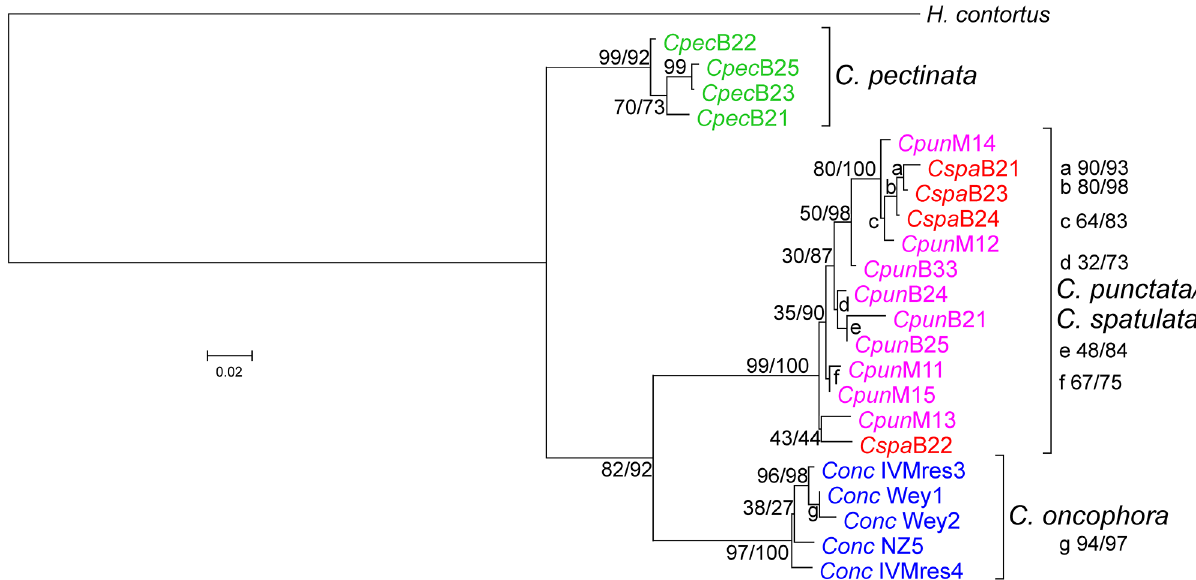
Fig 6. Multi-locus phylogenetic analysis of Cooperia species infecting cattle. Sequences were aligned using M-Coffee (partial isotype 1 β -tubulin and mitochondrial cox-2 genes) or MAFFT (partial ITS-1, complete 5.8S, ITS-2 fragment and partial mitochondrial 12S rRNA genes). Protein coding regions were manually edited to ensure that codons were not disrupted by gaps. A phylogenetic tree was calculated using RAxML with one partition per gene except for the cox-2 gene for which separate partitions for codon positions 1 and 2 and codon position 3 were included. Sequences from Haemonchus contortus (accession numbers DQ469245 + KT428386 + EU346694were used as outgroup. Samples were obtained from individual worms identified as Cooperiapectinata ( Cpec ,green), Cooperiapunctata ( Cpun , magenta) from Brazil, and Cooperiaspatulata ( Cspa , red) and from pools of larvae from Cooperia oncophora ( Conc , blue) and C . punctata from Mexico. Sequences derived from Brazil (B) and Mexico (M) are indicated together with numbers indicating the particular voucher (in combination with Cooperia morphospecies and geographical origin. The C . oncophora and the Mexican C . punctata samples were obtained from different pools of larvae using isolates that have been characterized as single species isolates. Node support values represent results of the rapid bootstrapping analysis before and of the Shimodaira-Hasegawa likelihood ratio test behind the slash. Accession numbers for all new sequences are available from S2